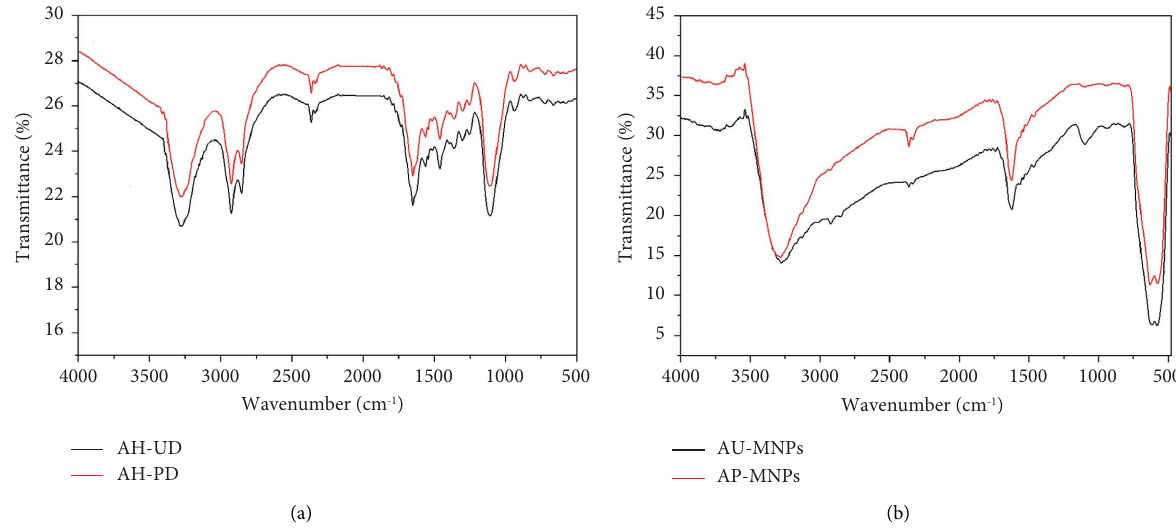
Figure 1: FTIR spectra of (a) polyamine, AH-UD and AH-PD, and (b) MNPs, AU-MNPs, and AP-MNPs.